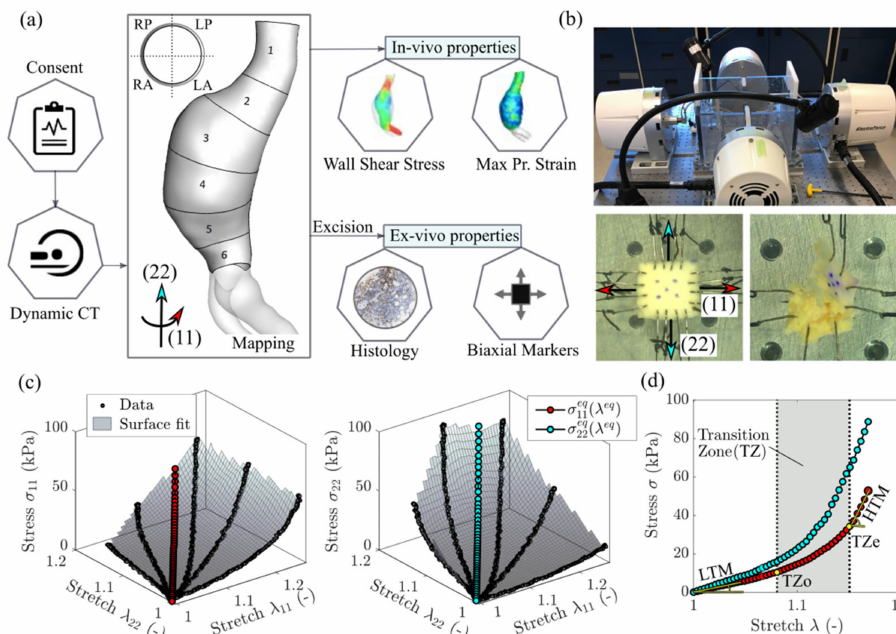
Figure 1. ( a ) Methodology summary and demonstration of the sampling grid defining the circumferential regions (RP—right posterior, LP—left posterior, RA—right anterior, LA—left anterior) and axial regions (1 to 6) of an aneurysm. ( b ) Biaxial testing setup and representative specimens: normal-sized specimen with four hooks per side and smaller specimen with two hooks per side. The latter is shown to fail due to tissue fragility. ( c ) A 3D representation of the biaxial data for a displacement-controlled test with different loading ratios. The surface interpolation is used to determine the equi-biaxial stretch-stress state. Stress and stretch are defined in the circumferential direction (11) and the longitudinal direction (22). ( d ) A 2D representation of the equi-biaxial stretch state and determination of all relevant mechanical properties—the low and high tangential modulus (LTM and HTM), the transition zone onset and end (TZo and